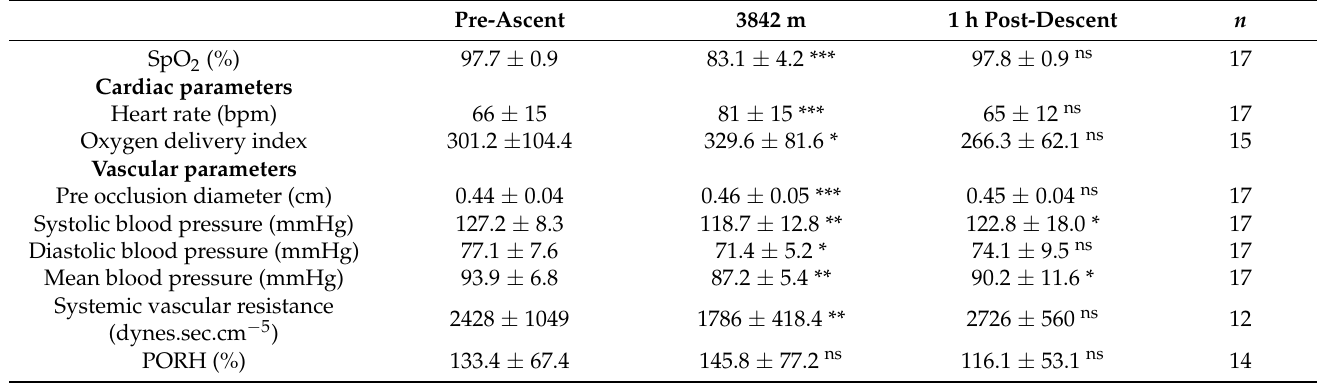
Table 1. Absolute values of the saturation, cardiac and vascular parameters before ascent, at 3842 m and 1 h after return to normobaric conditions. Results are given in mean ± SD. n = 17 for all parameters except oxygen delivery index ( n = 15), systemic vascular resistances ( n = 12) and PORH ( n = 14). Results are compared to pre-ascent values. * p < 0.05; ** p < 0.01; *** p < 0.001; ns p >